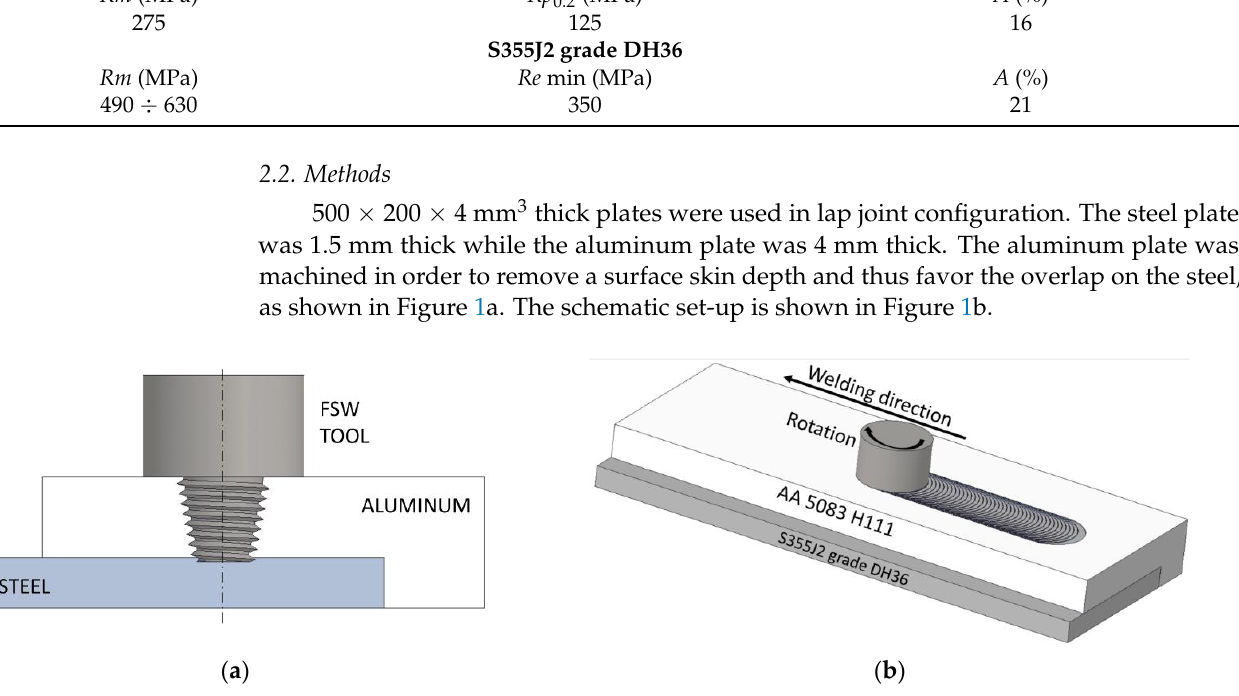
Figure 1. Schematic setup of the process in cross sectional ( a ) and axonometry ( b ) view. Tests were carried out with a H. Loitz-Robotik (Hamburg, Germany) machine with a nominal torque of 70 Nm up to 3050 rpm, a tilt angle range of +/−3°, and a maximum vertical force of 60 kN (Figure 2). In particular, the present paper focuses on specimens produced with 1° tilt angle.